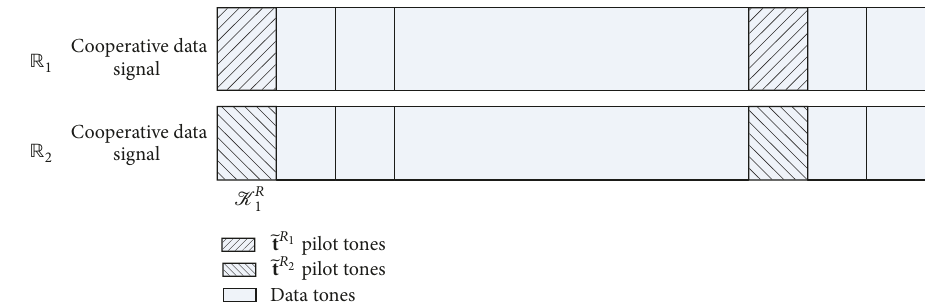
Figure 4: Sketch of the structure in the frequency domain for Scheme